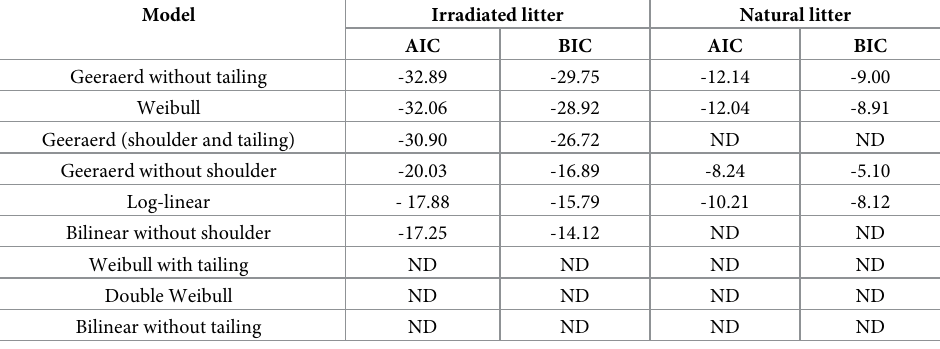
Table 2. Goodness-of-fit scores for inactivation models fitted to Salmonella Typhimurium (ST) survival data in irradiated and natural litter. Model Irradiated litter Natural litter AIC BIC AIC BIC Geeraerd without tailing -32.89 -29.75 -12.14 -9.00 Weibull -28.92 -8.91 Geeraerd (shoulder and tailing) -30.90 -26.72 ND Geeraerd without shoulder -20.03 -16.89 -8.24 -5.10 Log-linear - 17.88 -15.79 -10.21 -8.12 Bilinear without shoulder -17.25 -14.12 ND ND Weibull with tailing ND ND ND ND Double Weibull ND ND ND ND Bilinear without tailing ND ND ND ND ND, not determined (model could not be fitted to the data); AIC, Akaike information criterion; BIC, Bayesian information criterion.